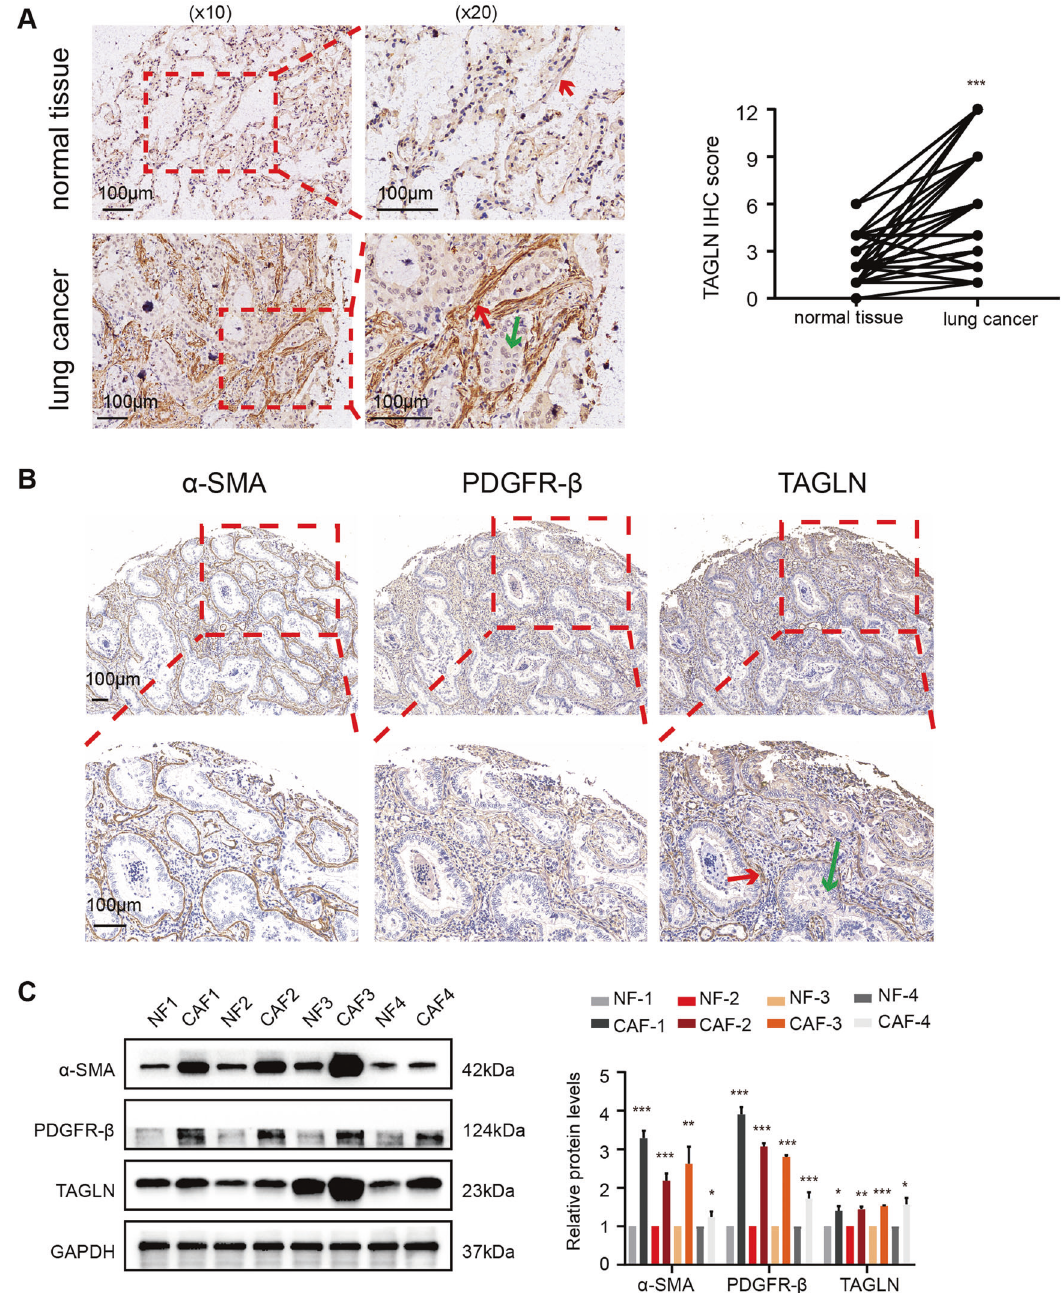
Fig. 1 Transgelin is highly expressed in human lung cancer stroma. A Immunohistochemical (IHC) staining for transgelin (TAGLN) in lung cancer and adjacent normal tissues from a tissue microarray of 94 tumors and 86 paired adjacent normal tissues. IHC score of transgelin in lung cancer and adjacent tissues. B IHC staining for TAGLN, α -SMA, and PDGFR- β in one patient from the human lung cancer tissue microarray ( n = 10). C Western blot analysis of protein levels of α -SMA, PDGFR- β , and TAGLN in CAFs and NFs (replicates from four patients). Red arrows represent stromal fi broblasts, green arrows represent lung cancer cells. Data are represented as mean ± SEM. *** p < 0.001, ** p < 0.01, * p < expression in the stroma of human lung cancer cells was test (for multiple comparisons), were performed. All values are presented as the mean ± standard error of mean (SEM). Differences were considered signi fi cantly higher than that in the stroma of normal lung tissue. statistically signi fi cant when p < 0.05 (* p < 0.05, ** p < 0.01, or *** p < 0.001). Co-localization of α -SMA, PDGFR- β , and TAGLN in three sequential sections of human lung cancer tissue microarrays revealed TAGLN localization in stromal fi broblasts (Fig. 1B). To further investigate RESULTS fi broblasts features and their interaction with tumor cells, CAFs TAGLN is highly expressed in lung cancer stroma and paired NFs were isolated from human lung cancer and First, we examined TAGLN expression in human lung cancer and adjacent non-tumor tissues. Fibroblasts were identi fi ed as CAFs adjacent non-tumor tissues through IHC. As shown in Fig. 1A, the mainly based on the analysis of α -SMA and PDGFR- β (Fig. 1C and